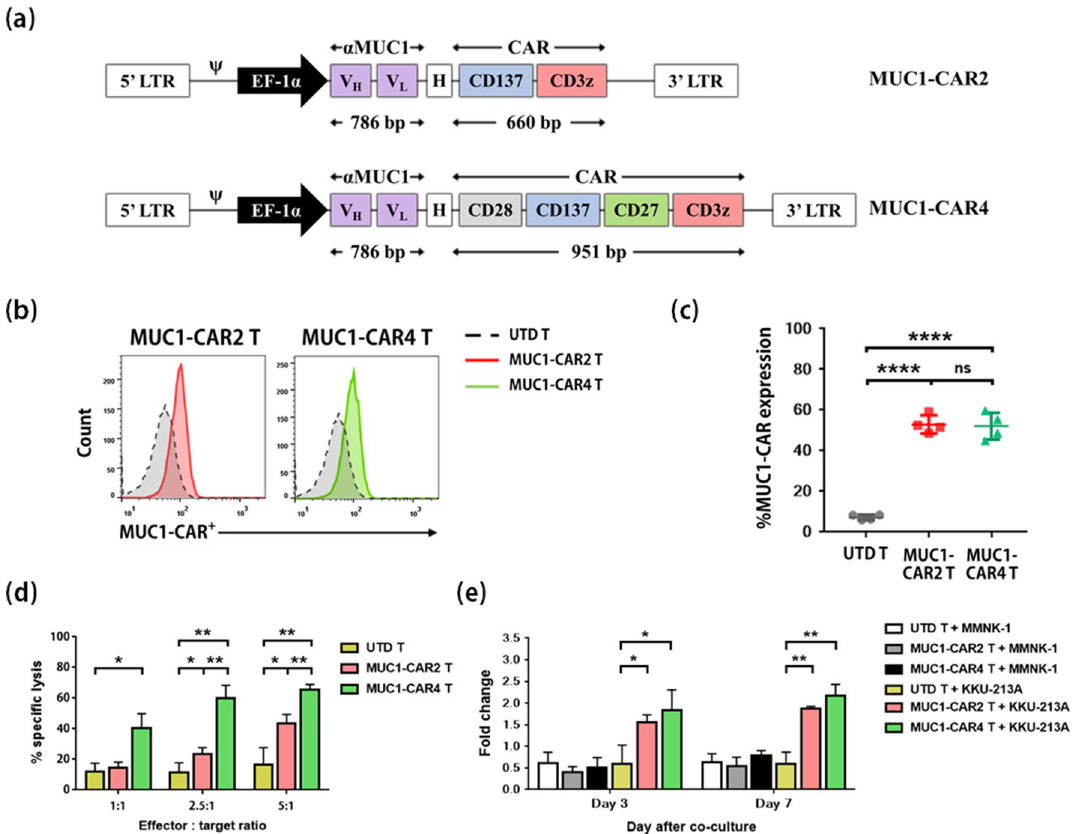
Figure 3. Anti-MUC1-CAR constructs, anti-MUC1-CAR T cell generation and their anti-tumor responses. ( a ) A schematic representation of the anti-MUC1-CAR2 (top) and anti-MUC1-CAR4 (bottom) lentiviral constructs. H represents hinge (spacer) domain. ( b ) Representative transduction efficiency of the untransduced T cells (UTD, gray), anti-MUC1-CAR2 T cells (red), and anti-MUC1-CAR4 T cells (green) detected by flow cytometry. ( c ) The transduction efficiency summarized from 4 independent experiments. ( d ) The bar graph represented percentages of KKU-213A cell lysis from 3 independent experiments. ( e ) T cell expansion after exposure to either MMNK-1 or KKU-213A cells. All data with error bars represents mean ± SD. Statistical differences were analyzed by Student t -test (asterisks indicate p -values: * p < 0.05, ** p < 0.01, *** p < 0.001 and **** p <